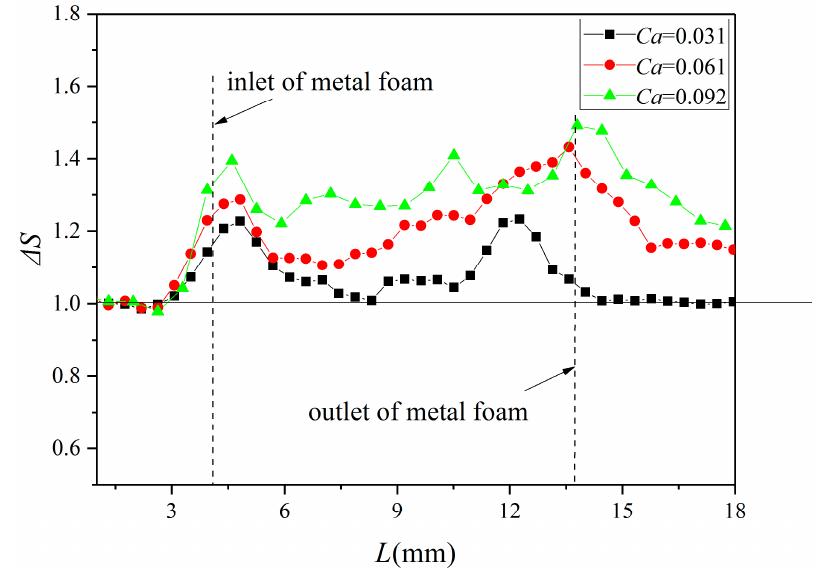
Figure 6. Change of the superficial area of the droplet passing through metal foam with different Ca values ( L d = 7.32; D d = 1.82).